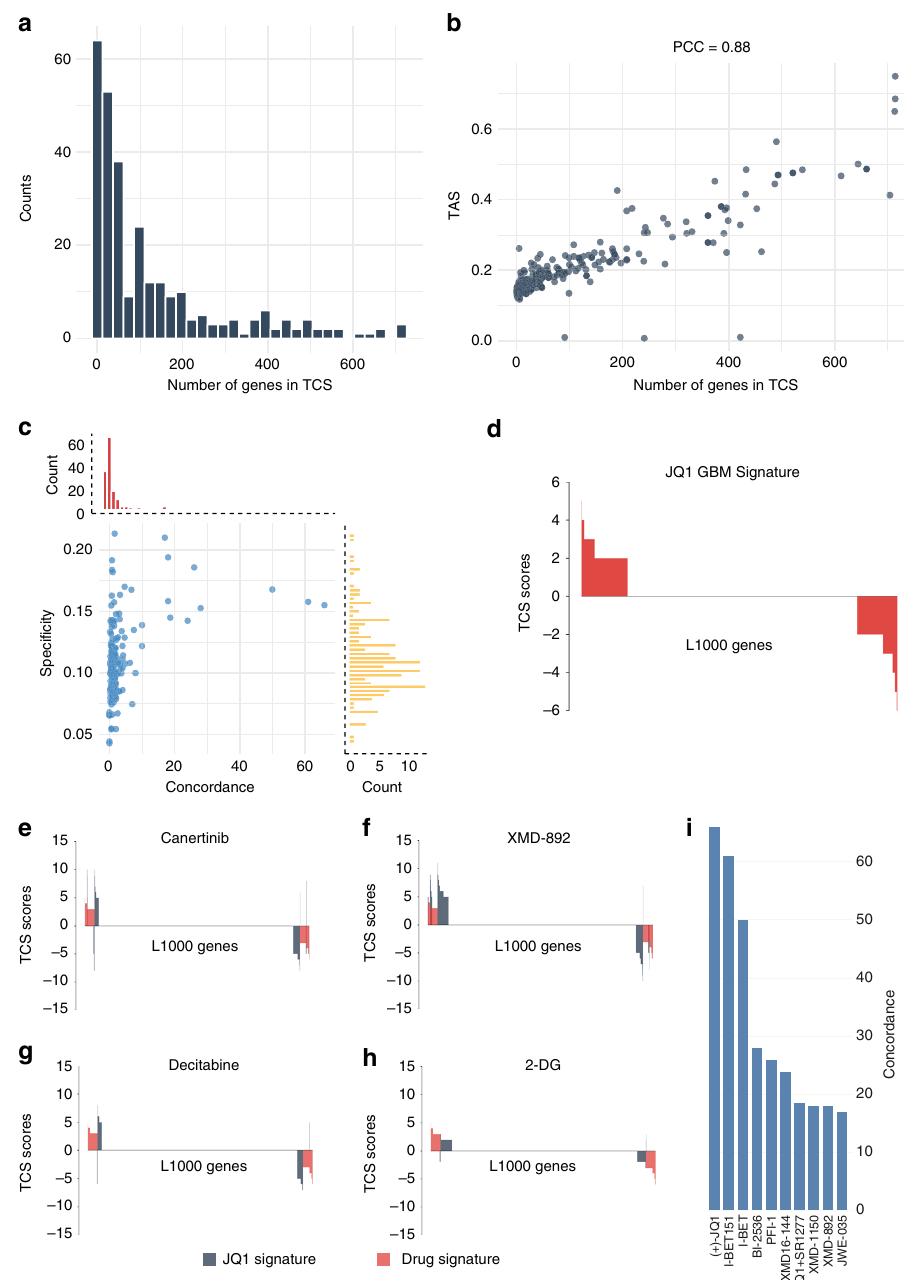
Fig. 3 Transcriptional consensus signatures can identify common transcriptional responses to compounds. a Histogram of the number of genes in the TCS per compound. Most of the compounds tested have a low number of genes in their TCS. b The number of genes that each compound has in its TCS is correlated with the Transcription activity score, a metric for the consistency in a compound ’ s transcriptional response. PCC: Pearson correlation coef fi cient. c Speci fi city and concordance of L1000 compounds compared to the JQ1 TCS. Only a few compounds overlap and have a concordant transcriptional response with the JQ1 TCS. d The JQ1 Transcriptional response signature. The top two ( e , f ) and the bottom two ( g , h ) compounds with the highest speci fi city to the JQ1 TCS. i The top 10 compounds with the highest concordance to the JQ1 TCS are BET